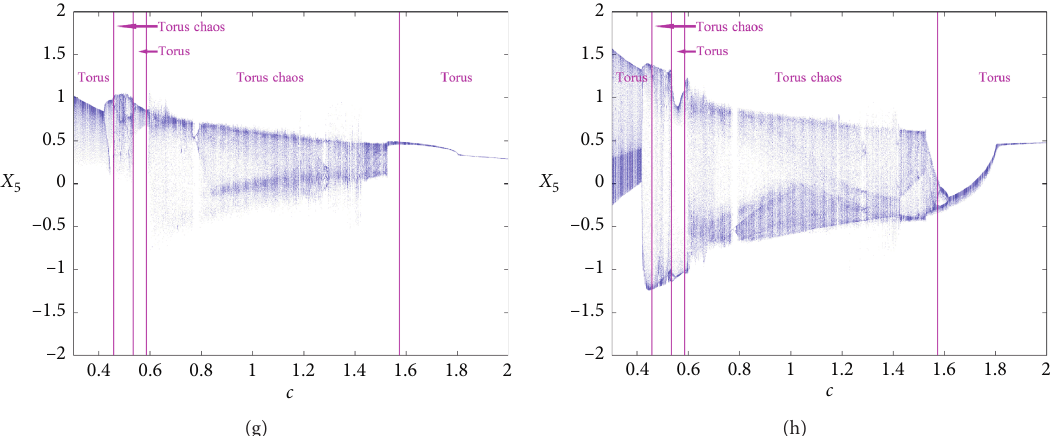
Figure 9: LEs spectrum, Kaplan–Yorke dimension spectrum, and bifurcations of (2) as the coefficient c is varied over the range c ∈ [0.3, 2].